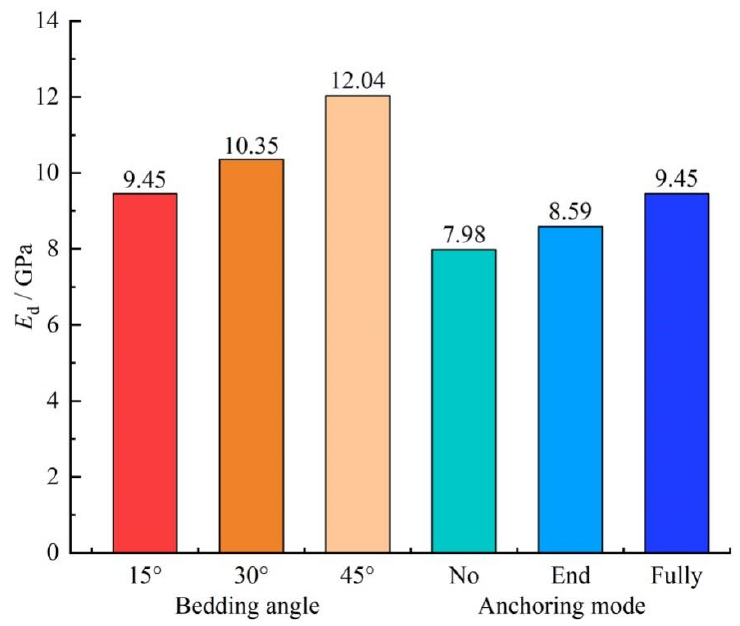
Figure 9. Dynamic elastic modulus ( E d ).